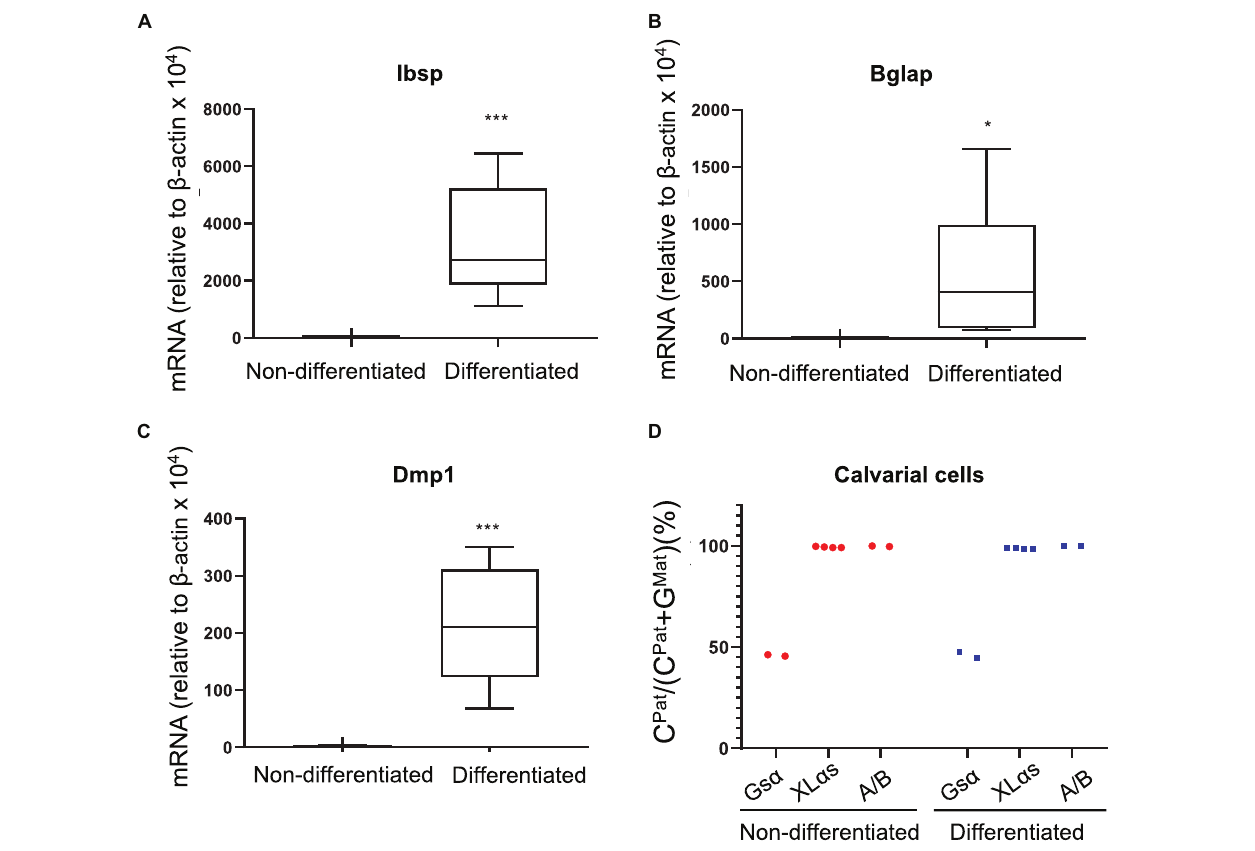
FIGURE 3 | Allele-specific XL α s expression in cultured preosteoblasts and osteoblasts is almost exclusively paternal. The mRNA levels of osteoblast markers Ibsp (A) , Bglap (B) , and Dmp1 (C) were measured to confirm osteoblastic differentiation of calvarial preosteoblasts. qRT-PCR was used with β -actin as reference control. * p < 0.05; *** p < 0.001 vs. non-differentiated by two-tailed Student’s t -test ( n = 7). (D) Percent of C-containing (paternal) NGS reads in RT-PCR amplicons from Gs α , XL α s, and A/B transcripts in non-differentiated and 14 day-differentiated preosteoblasts. Data are from individual F1 mice of C57BL/6 × 129/Sv